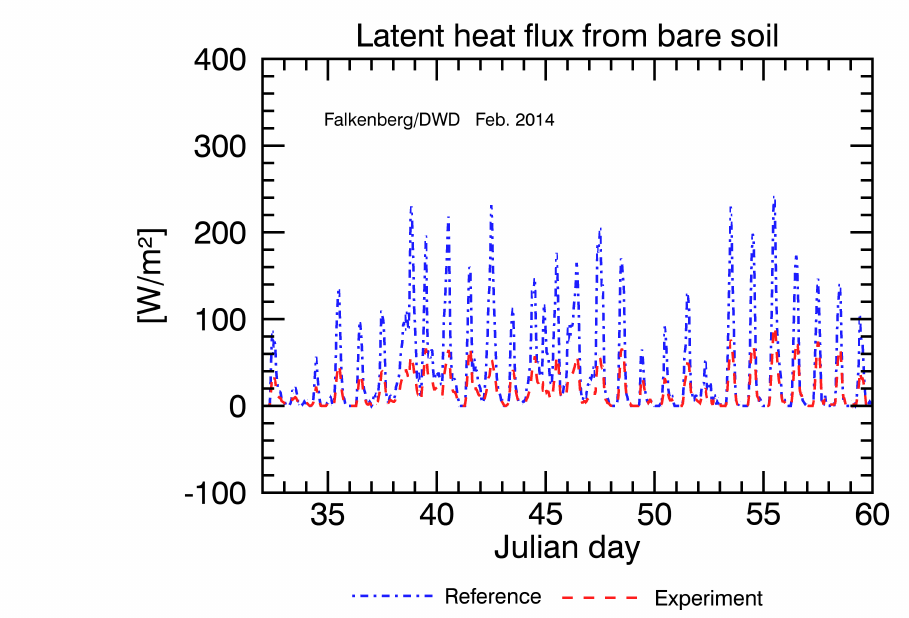
Figure 1. Diurnal cycles of the latent heat flux from bare soil at Falkenberg on 1–28 February 2014 (Julian day 32–59) as simulated by the reference version of TERRA based on BATS [21] and by the new scheme based on a resistance formulation (experiment).